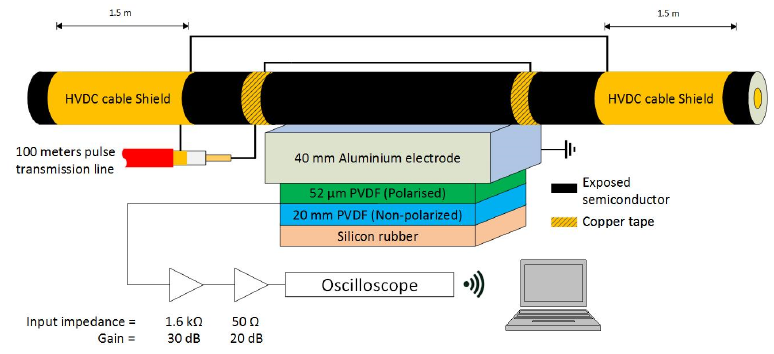
Figure 1. Representation of the PEA test cell including the acoustic sensor, amplifier, and